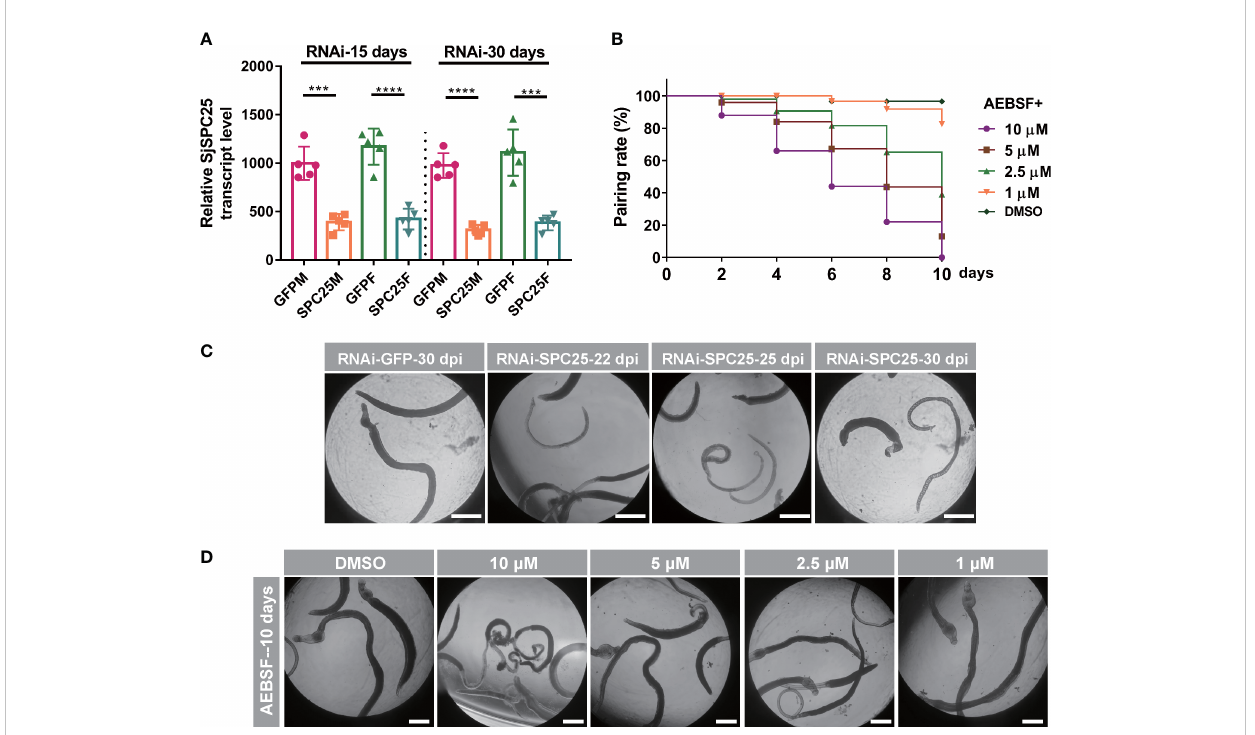
FIGURE 7 Worm activity analyses of inhibition of SPC25 function in vitro . (A) Ef fi cacy assessment of dsRNA-mediated SPC25 knockdown of worm collected on the 15 dpi and 30 dpi. (B) Effects on worm motility of dsSPC25 treatment. All experiments were performed in triplicate with fi ve biological replicates, and each group ’ s data were shown as means ± SEM. (C) The pairing rate of the inhibitor ABSEF treated worms in vitro. (D) Detection of visible abnormalities in ABSEF treated worms. Three independent biological replications were performed. And the well had six fresh pairs of worms for each biological experiment. *** p < 0.001, **** p < 0.0001,